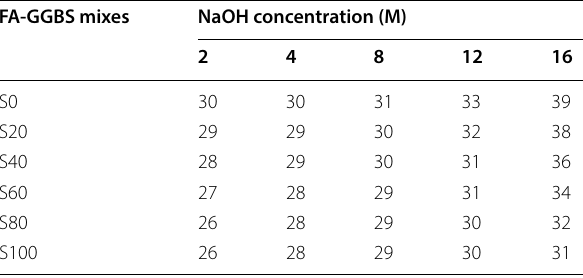
Table 2 Normal consistency values (%) of